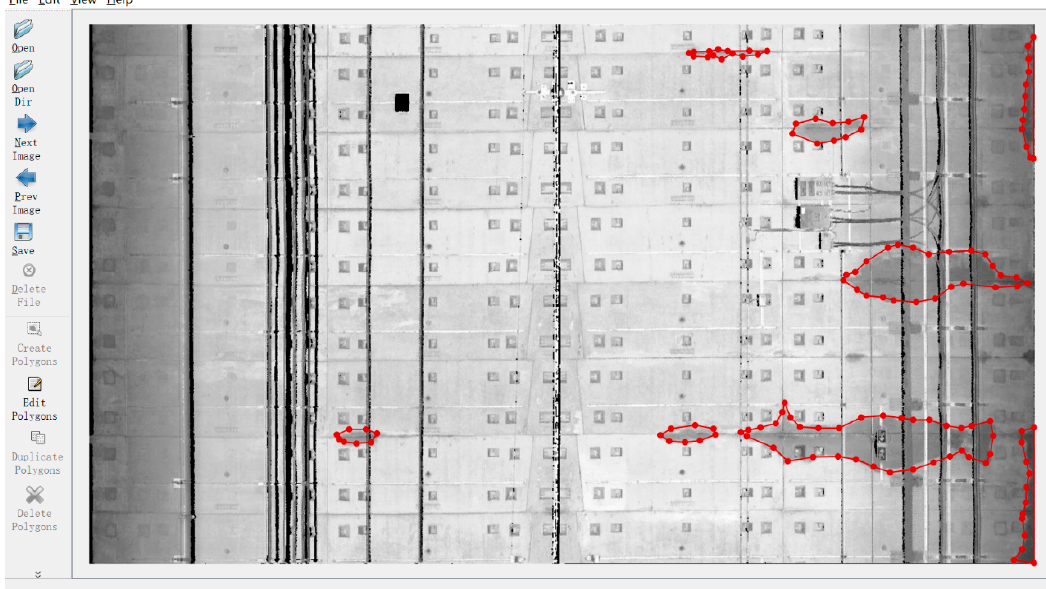
Figure 8. Water leakage annotated by LabelMe software.